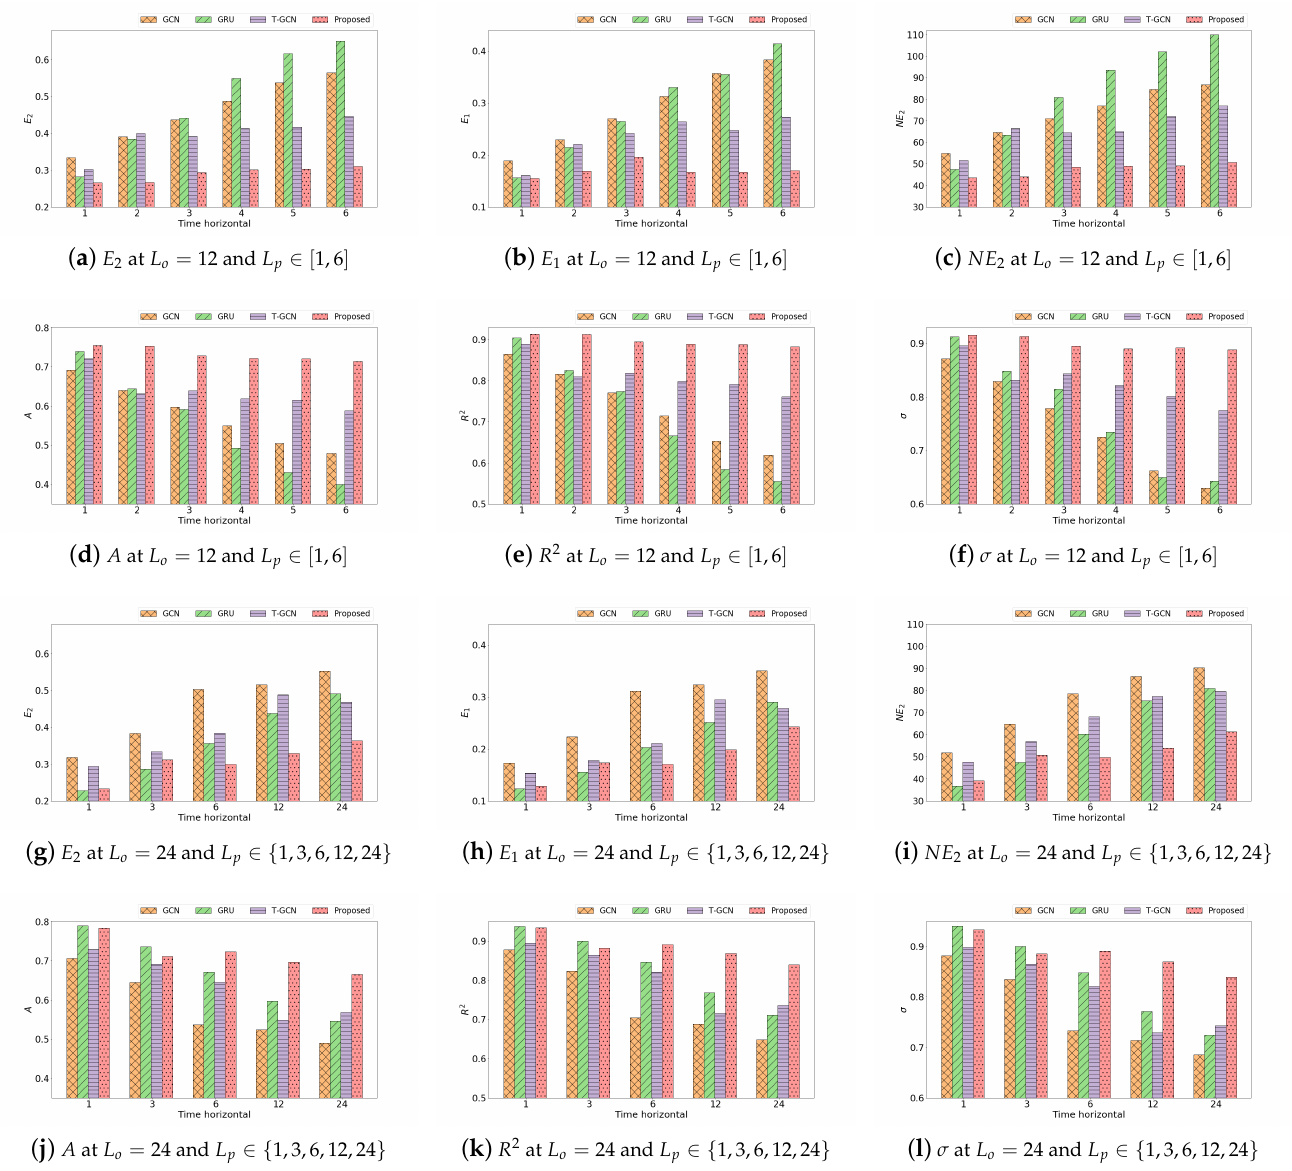
Figure A3. The performance comparison of the proposed model with the existing models according to changes in the prediction and observation periods. X-axes of the plots indicate the prediction sequence length, and Y-axes correspond to the evaluation metrics. L p and L o denote the prediction and observation sequence lengths,